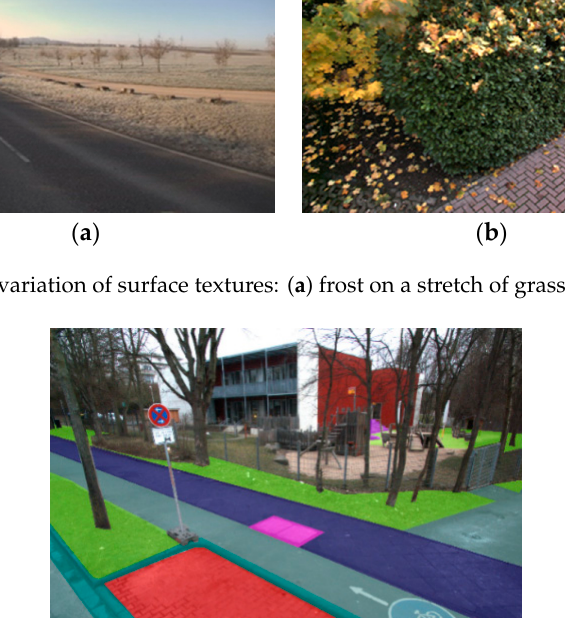
Figure 3. Seasonal variation of surface textures: (a) frost on a stretch of grass; (b) shedded leaves .